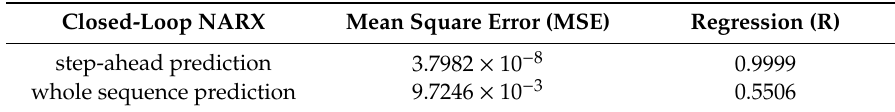
Table 3. Closed-loop NARX training results.